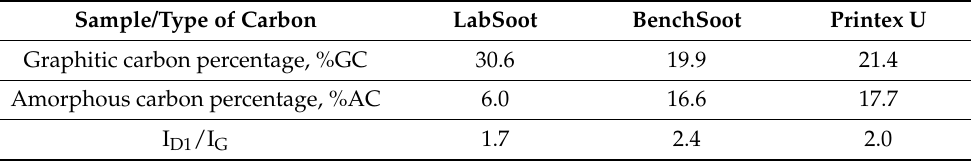
Table 2. Graphitic and amorphous contents and disorder degree for the different samples of